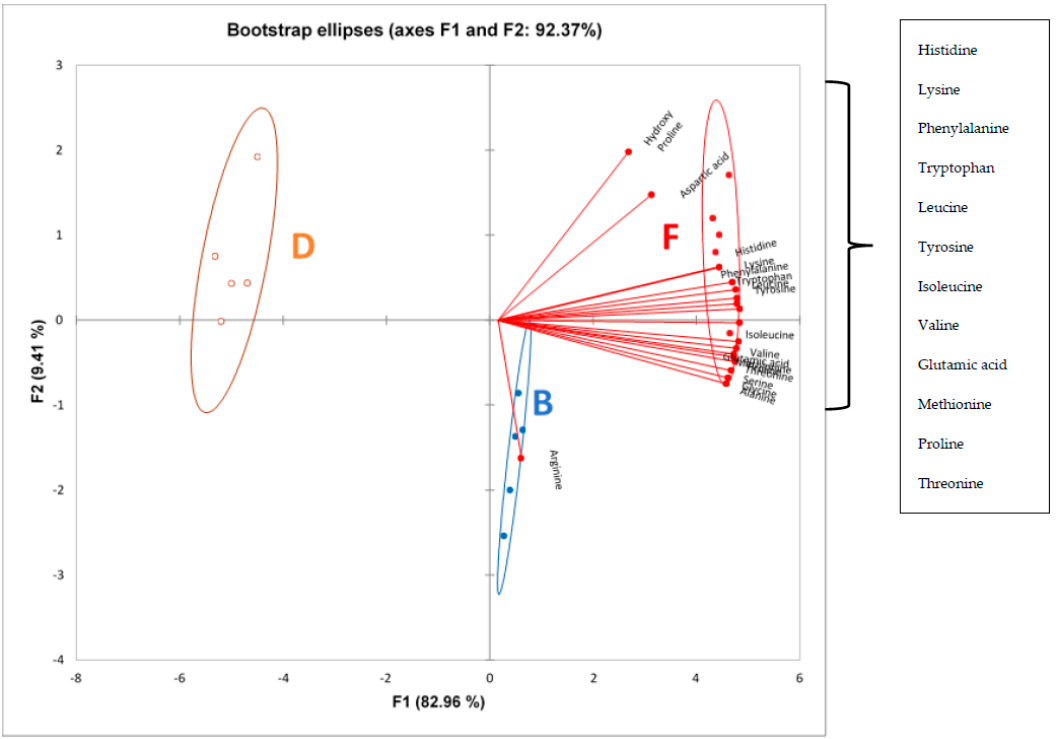
Figure 2. Principal component analysis biplot with bootstrapped confidence ellipses at 95% confidence level for amino acid composition determined using LCMS for sourdough samples B, F and D.